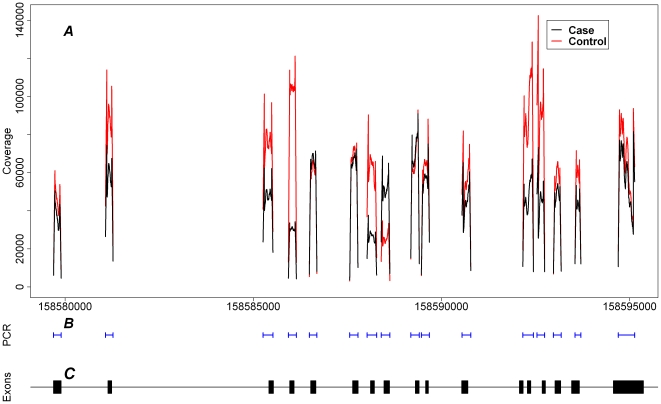
Depth of coverage.A: The depth of coverage at each position where the X axis shows the genomic position on chromosome 1 (hg18, Mar. 2006). B: Locations of the PCR products aligned to the X axis. C: Locations of the Exons of Nicastrin aligned to the X axis.